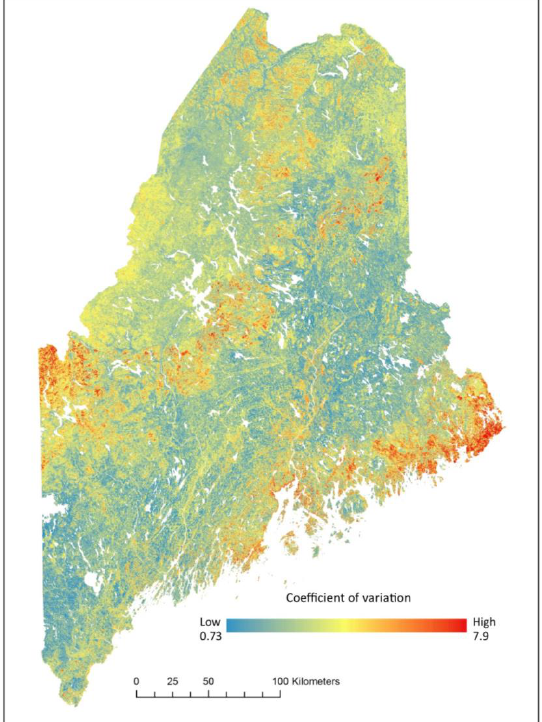
Figure 9. Prediction uncertainty of Tsuga canadensis relative basal area for RCP 8.5 in the year 2050 mapped as a coefficient of variation (%) of all trees used in the random forest algorithm.